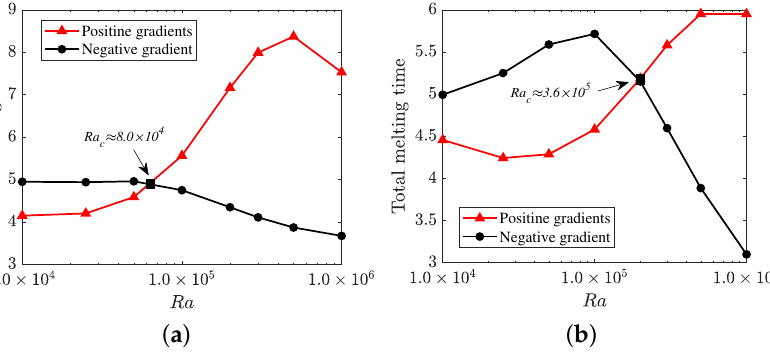
Figure 7. Comparisons of total melting time in two different gradient structure for different Ra , in which Ste = 0.1, and Pr = 0.2: ( a ) Case A; ( b ) Case B.